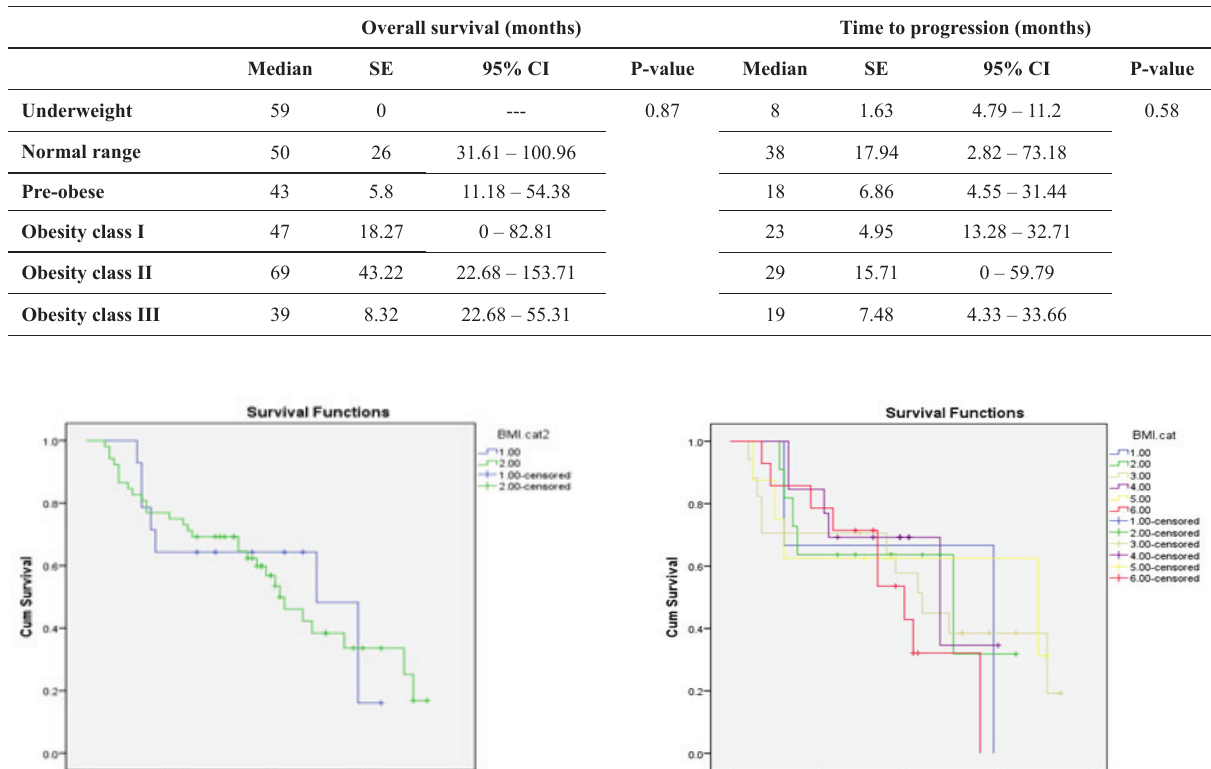
table 6: Estimated overall survival and time to progression according to BMI.